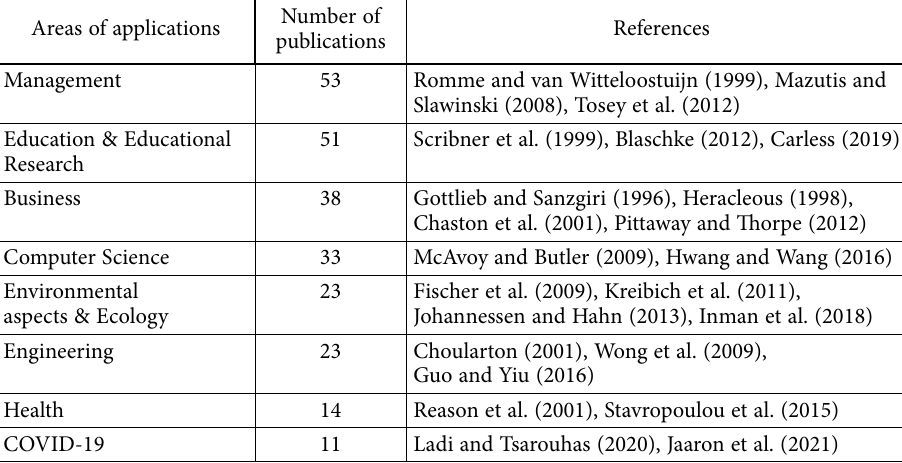
Table 1. Areas of application of the concept of double-loop learning in the literature on the subject Areas of